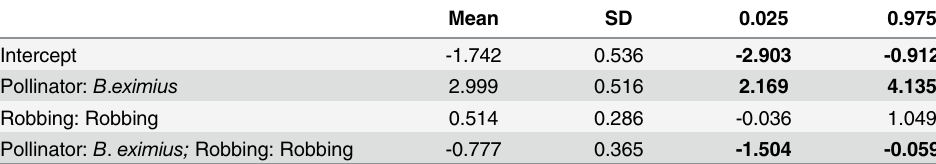
Table 4. Pollinator visitation rates with respect to robbing between robbed and unrobbed FDPs.